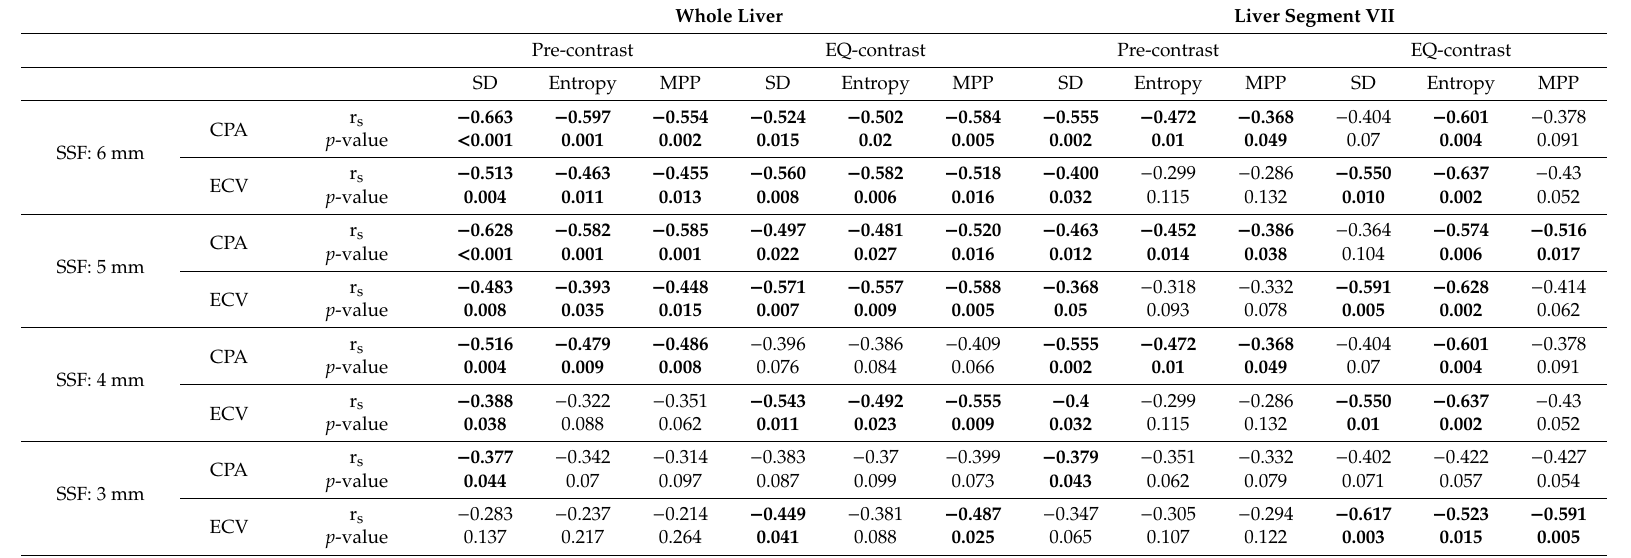
Table 2. Texture liver analysis results of mean and skewness at di ff erent SSFs vs. ELF. Bold indicates statistical significance. (SSF: spatial scaling factor, r s : Spearman’s rank correlation coe ffi cient, ELF: enhanced liver fibrosis, and ECV: extracellular